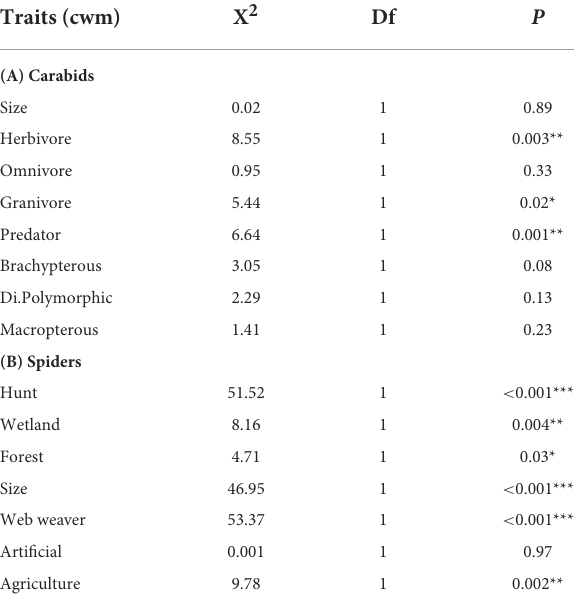
TABLE 4 Summary tables of χ 2 tests applied on linear mixed models testing the impact of system type (OC and CV) on each trait expressed as community weighted mean (cwm) for carabids (A) and spiders